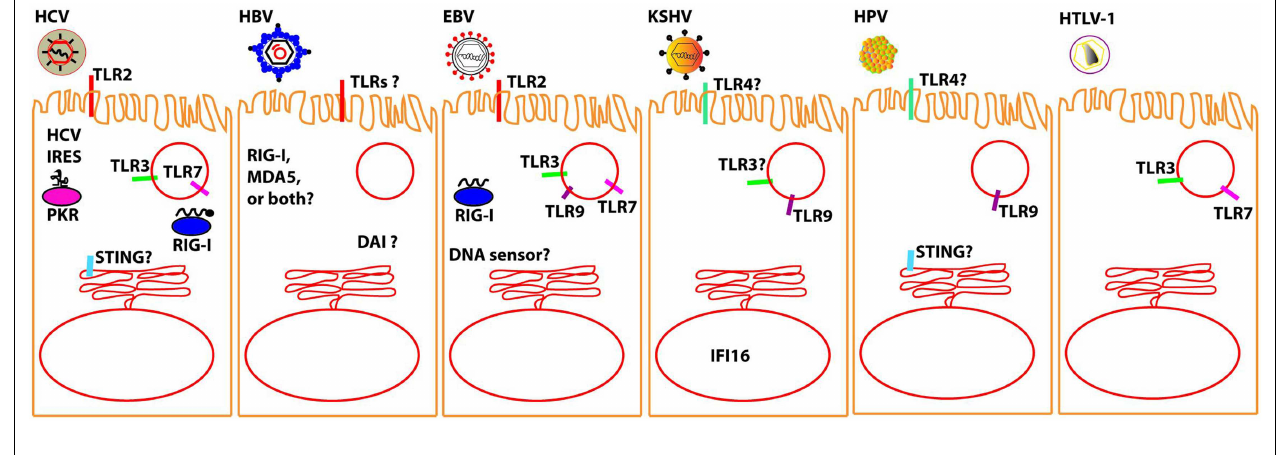
the proposed sensor awaits verification in relevant in vivo models. Question marks are intended to denote those sensors for which there is particularly conflicting data; please see specific sections in text for further